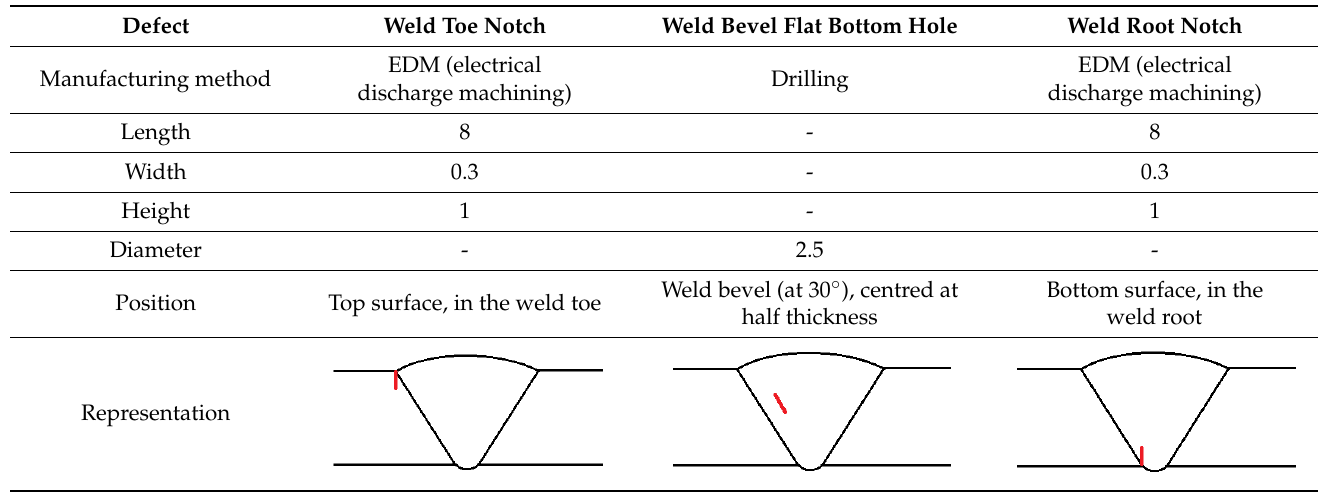
Table 2. Artificially manufactured defects characterization.